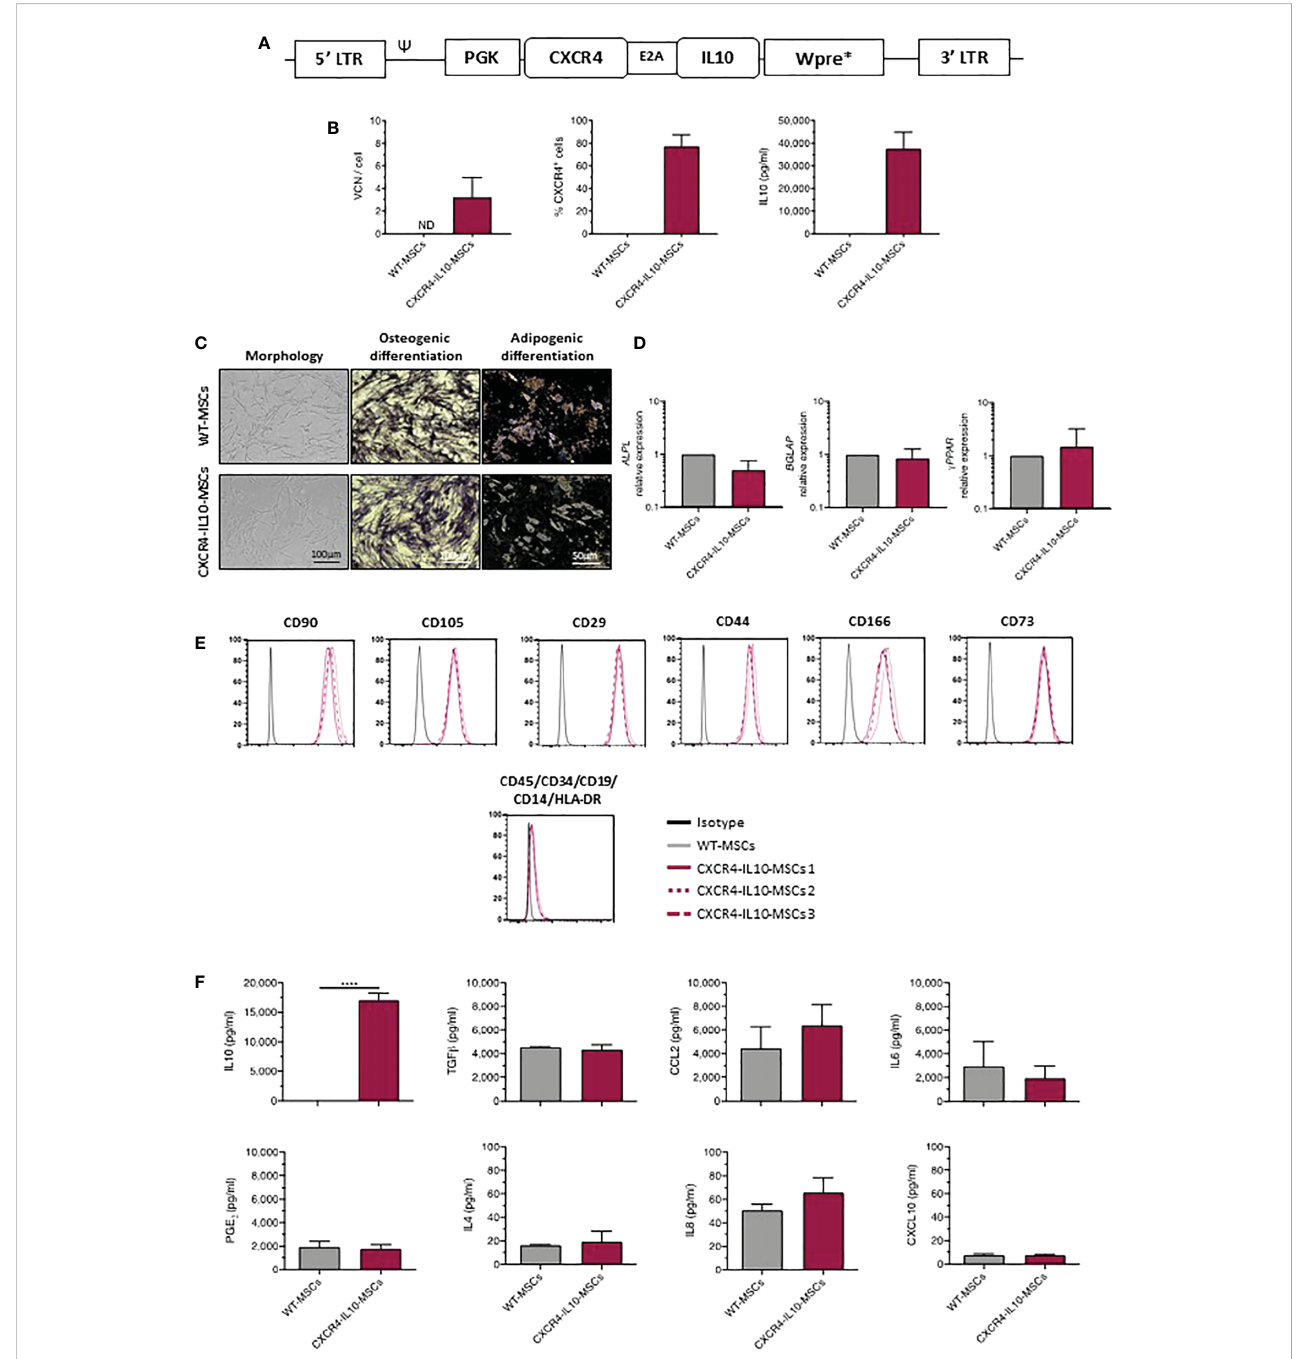
FIGURE 1 Phenotypic characterization of MSCs transduced with a lentiviral vector carrying the CXCR4 and IL10 cDNAs (CXCR4-IL10-MSCs). (A) Description of the bicistronic LV carrying the codon-optimized cDNA sequences of CXCR4 and IL10 (PGK.CXCR4-IL10.Wpre*) used to transduce MSCs. (B) Analysis of the vector copy number per cell (VCN/cell) and of the percentage of CXCR4 + MSCs ( fl ow cytometry analysis) and levels of secreted IL-10 (ELISA analysis) corresponding to WT-MSCs and CXCR4-IL10-MSCs. Analyses were performed in cells maintained for 2 weeks in culture after transduction. (C) Representative images of morphology, osteogenic (alkaline phosphatase deposits) and adipogeneic differentiation (presence of lipid droplets) of WT- MSCs and CXCR4-IL10-MSCs (D) mRNA expression analyses showing ALPL and BGLAP expression, characteristic of osteogenic differentiated cells, and of g -PPAR , characteristic of adipogeneic differentiated cells. (E) Immunophenotype analysis of undifferentiated WT-MSCs and CXCR4-IL10-MSCs. Representative analyses of characteristic MSC markers are shown. (F) Levels of secreted cytokines corresponding to WT-MSCs and CXCR4-IL10-MSCs determined 24h after medium change. Bars represent the mean ± SD of n = 3 different experiments. ****p<0.0001; ND = not